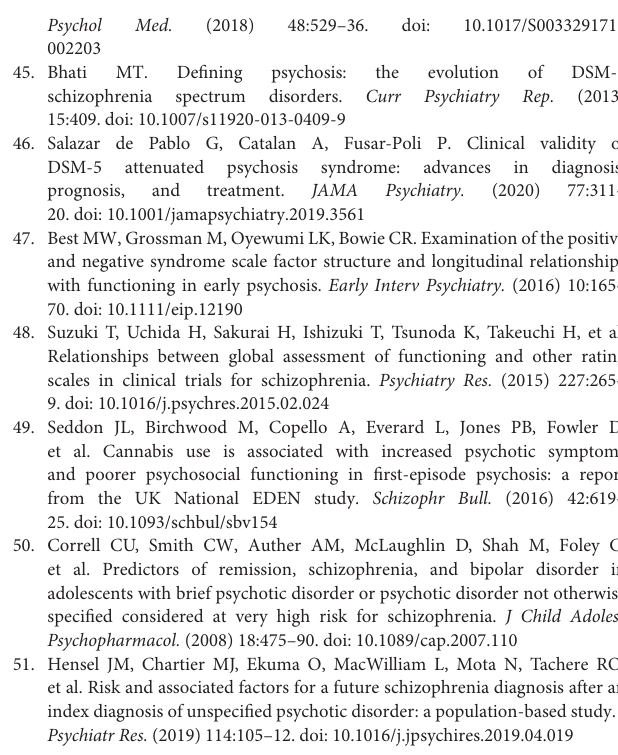
index diagnosis of unspecified psychotic disorder: a population-based study. J Psychiatr Res. (2019) 114:105–12. doi: